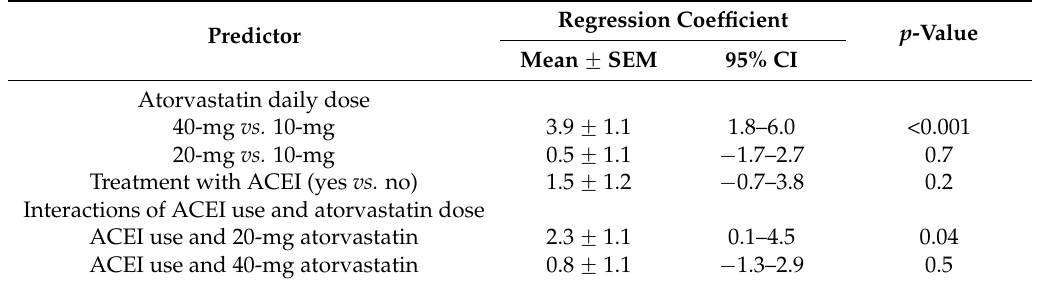
Table 3. Multiple linear regression analysis of predictors a change in GFR over 1 year.